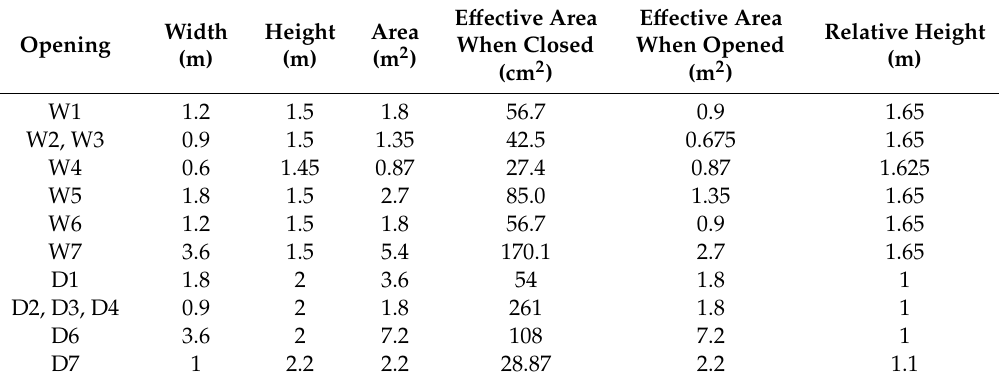
Table 1. The size and the e ff ective area of each opening.